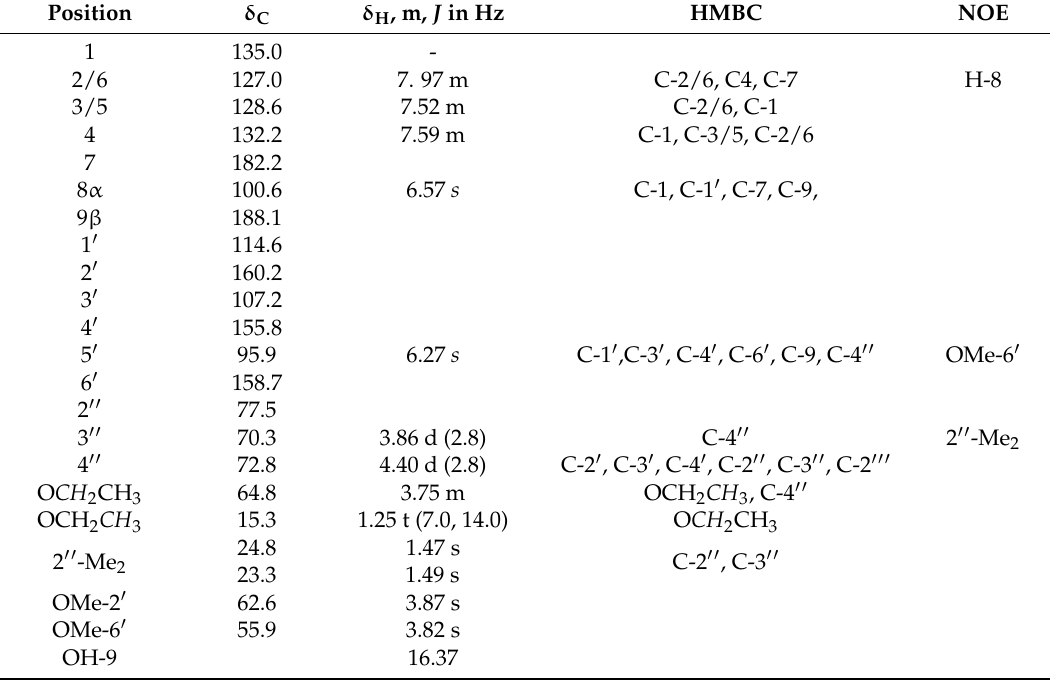
Table 2. 1 H (600 MHz) and 13 C (150 MHz) NMR data for aequichalcone C ( 3 ) acquired in CD 2 Cl 2 at 25 ◦